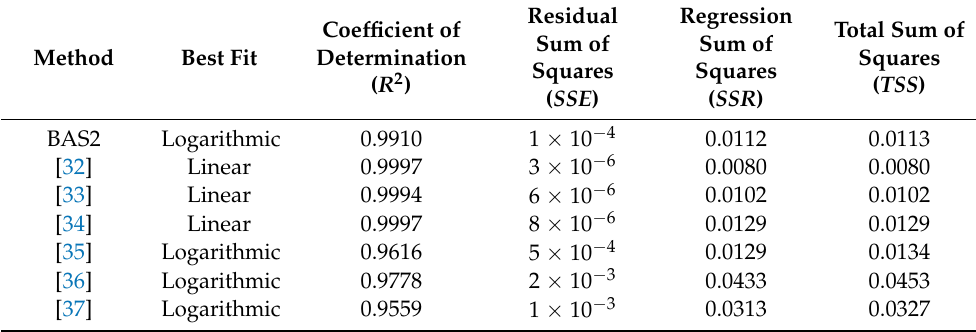
Regression Residual Total Sum of Coefficient of Sum of Sum of Squares Determination Squares Squares ( TSS ) ( R 2 ) ( SSR ) ( SSE )